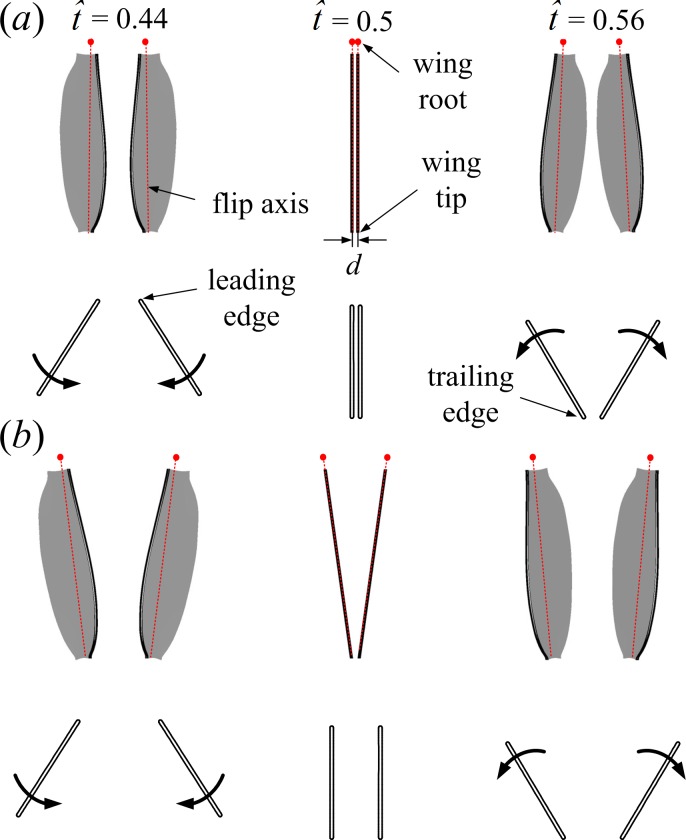
Motions of the wing pair (3D, top view) and the corresponding wing sections (2D, side view) at half-wing length for the full (A) and the partial (B) clap-fling at three time instances (\documentclass[12pt]{minimal}
\usepackage{amsmath}
\usepackage{wasysym}
\usepackage{amsfonts}
\usepackage{amssymb}
\usepackage{amsbsy}
\usepackage{upgreek}
\usepackage{mathrsfs}
\setlength{\oddsidemargin}{-69pt}
\begin{document}
}{}$\hat {t}=0.44$\end{document}t ˆ=0.44, \documentclass[12pt]{minimal}
\usepackage{amsmath}
\usepackage{wasysym}
\usepackage{amsfonts}
\usepackage{amssymb}
\usepackage{amsbsy}
\usepackage{upgreek}
\usepackage{mathrsfs}
\setlength{\oddsidemargin}{-69pt}
\begin{document}
}{}$\hat {t}=0.5$\end{document}t ˆ=0.5 and \documentclass[12pt]{minimal}
\usepackage{amsmath}
\usepackage{wasysym}
\usepackage{amsfonts}
\usepackage{amssymb}
\usepackage{amsbsy}
\usepackage{upgreek}
\usepackage{mathrsfs}
\setlength{\oddsidemargin}{-69pt}
\begin{document}
}{}$\hat {t}=0.56$\end{document}t ˆ=0.56) during dorsal stroke reversal.